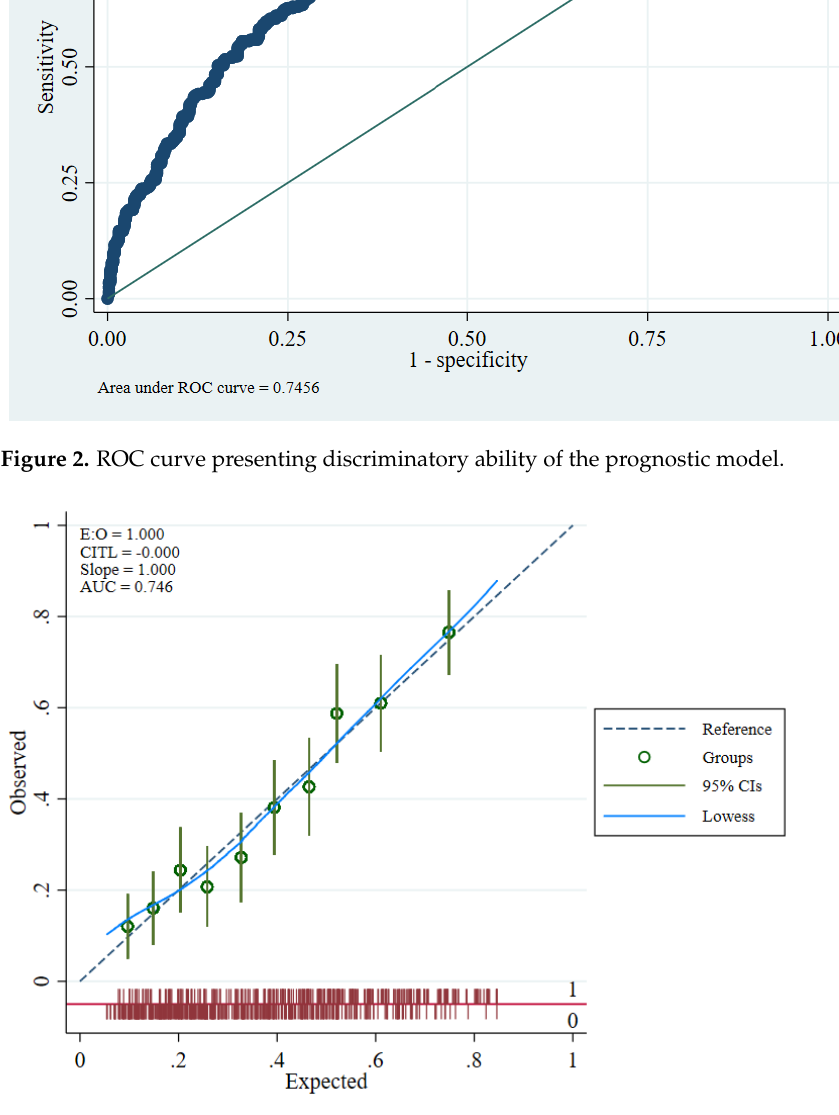
Figure 3. PMCA plot presenting calibration of the prognostic model by comparing observed and expected expected outcomes.